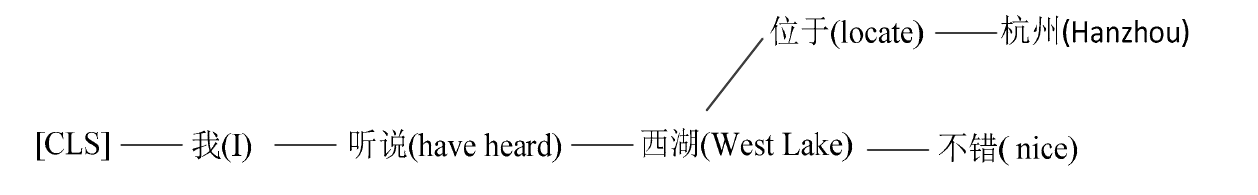
Table 4. Experimental results of ablation experiments using the CwConvRec dataset. Models